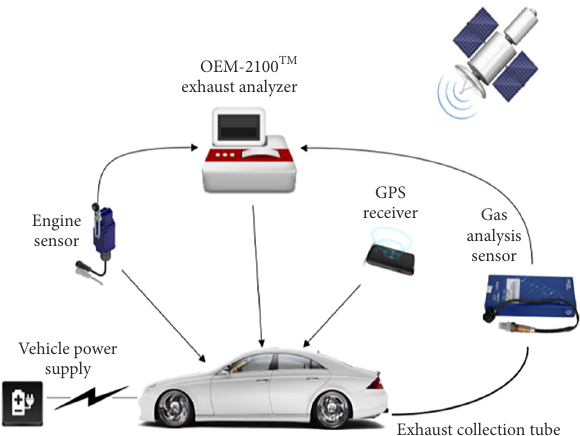
Figure 1. On-board emission test platform light-duty vehicles